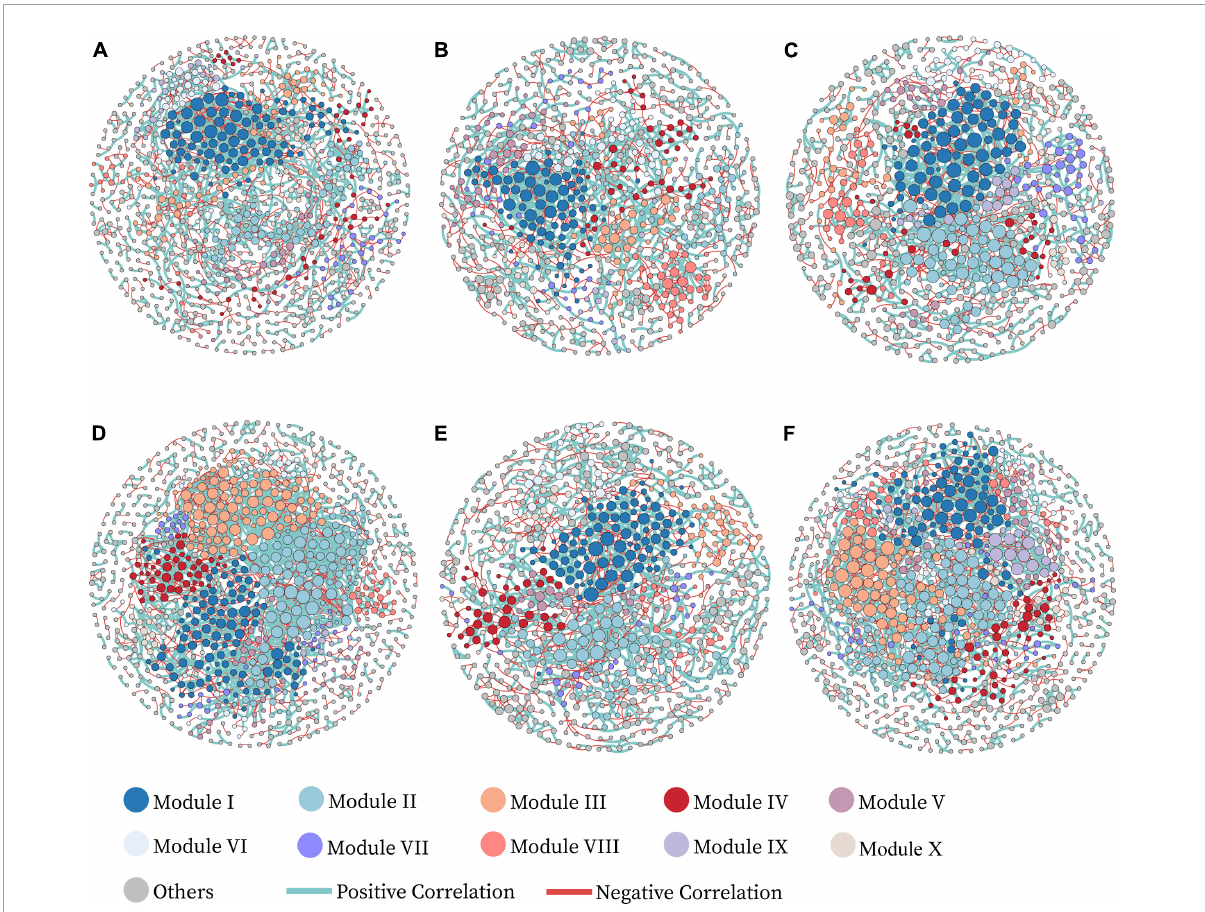
FIGURE2 Visualized networks of microbial co-occurrence in different treatments, (A–F) represent the networks of treatments XRZS0, JRZS0, NRZS0, XRZS2, JRZS2, and NRZS2, respectively. The nodes are colored by module. The module eigengenes from the top 10 large sub-modules explained 41.25–58.81% of the variations of the relative abundance across different replicates, suggesting that these eigengenes represented the module profiles relatively well. Nodes represent an operational taxonomic unit (97% sequence identifies a threshold, OTU). The size of each node is proportional to the node degree. The edges in green and red represent co-occurrence and mutual exclusion patterns among